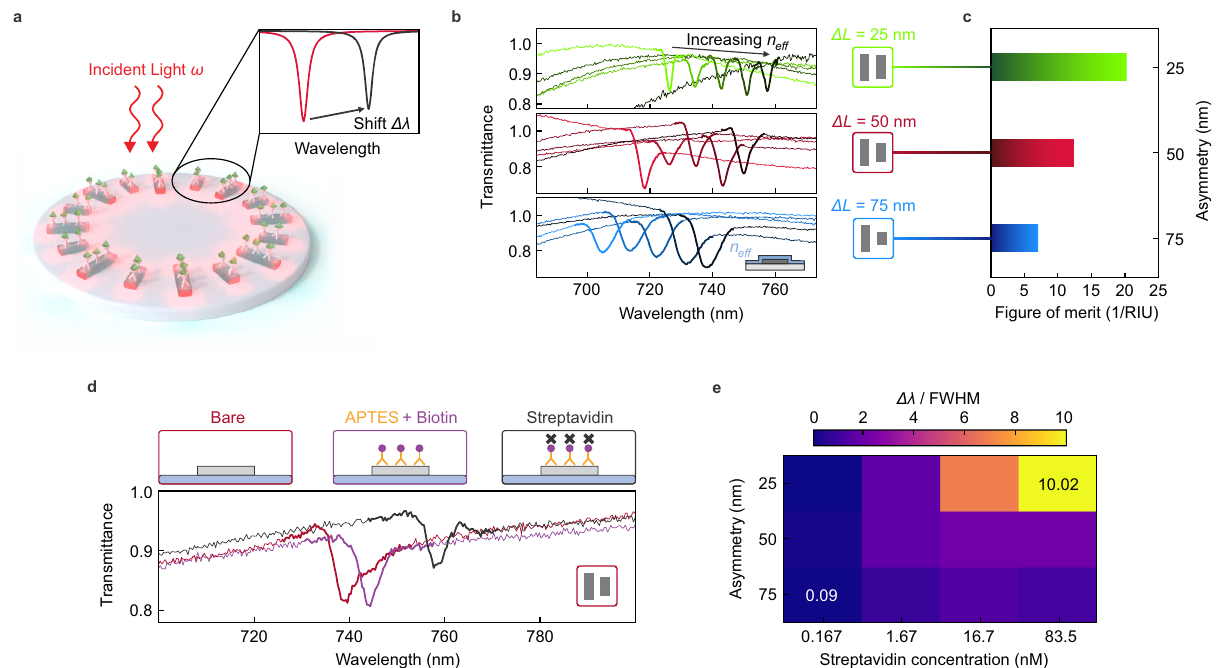
Fig. 3 | Refractive index and molecular biosensing withradial BICs.a Sketch of the biosensing experiments. The ring structures are functionalized with cap- ture antibodies, and shifts in the spectral position of the resonance are recorded for the binding of different concentrations of biomolecules. b Optical transmittance spectra of three-unit cell asymmetries Δ L with R = 1.5 µ m covered with different thicknesses of conformal SiO